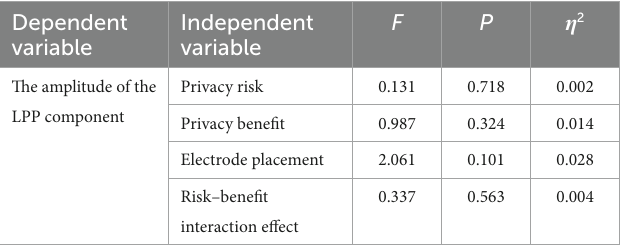
TABLE 5 ANOVA results for LPP component. Dependent variable